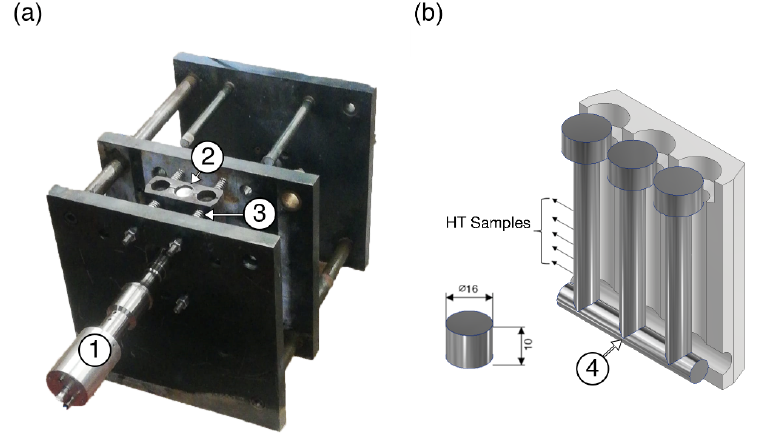
Figure 1. ( a ) Experimental setup and ( b ) representation of samples for microstructural and mechanical characterization. (1) Piezoelectric transducer, booster, and waveguide (the last is coupled directly to the exterior mold wall); (2) Steel mold supported by four shafts (3) and compression springs. The thermal behavior was recorded by a thermocouple (4) positioned in the casting’s hot area.